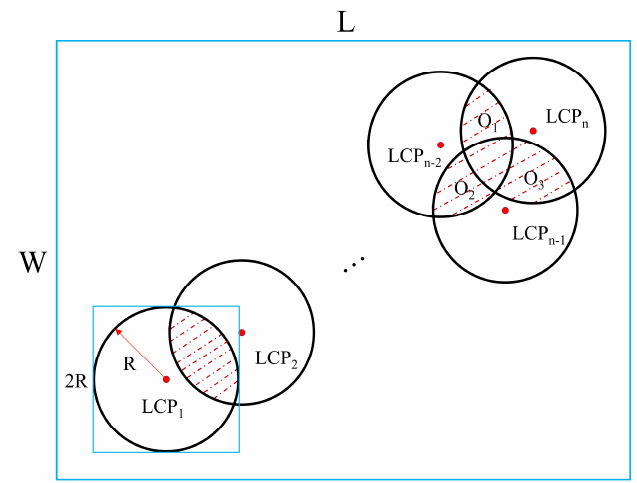
Figure 4. How to generate individual and overall landslide Gaussian heatmaps.